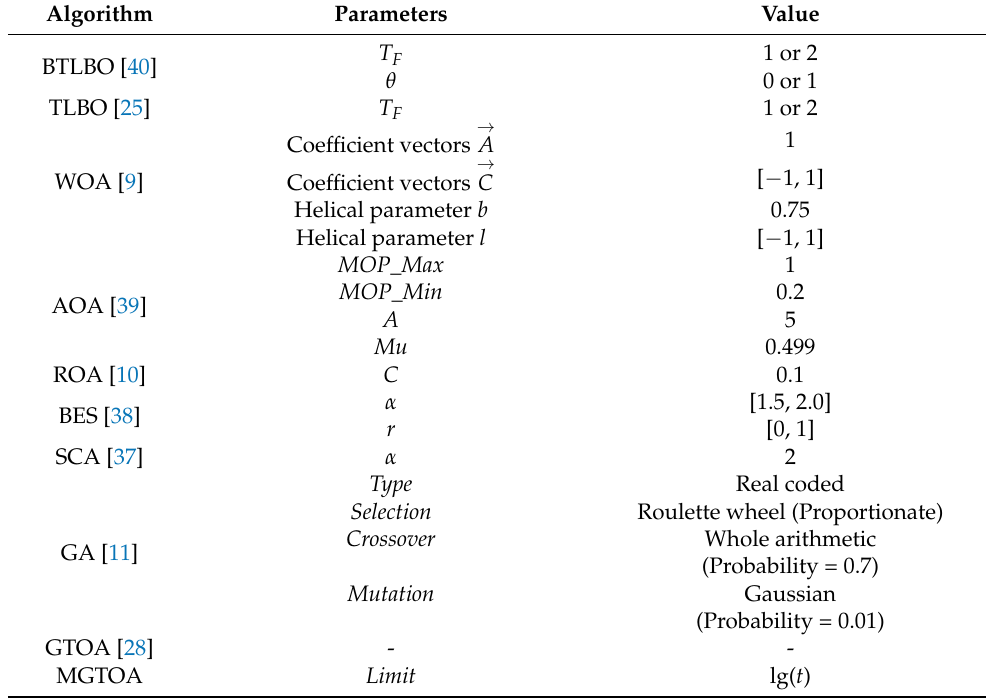
Table 1. Parameter settings for the comparative